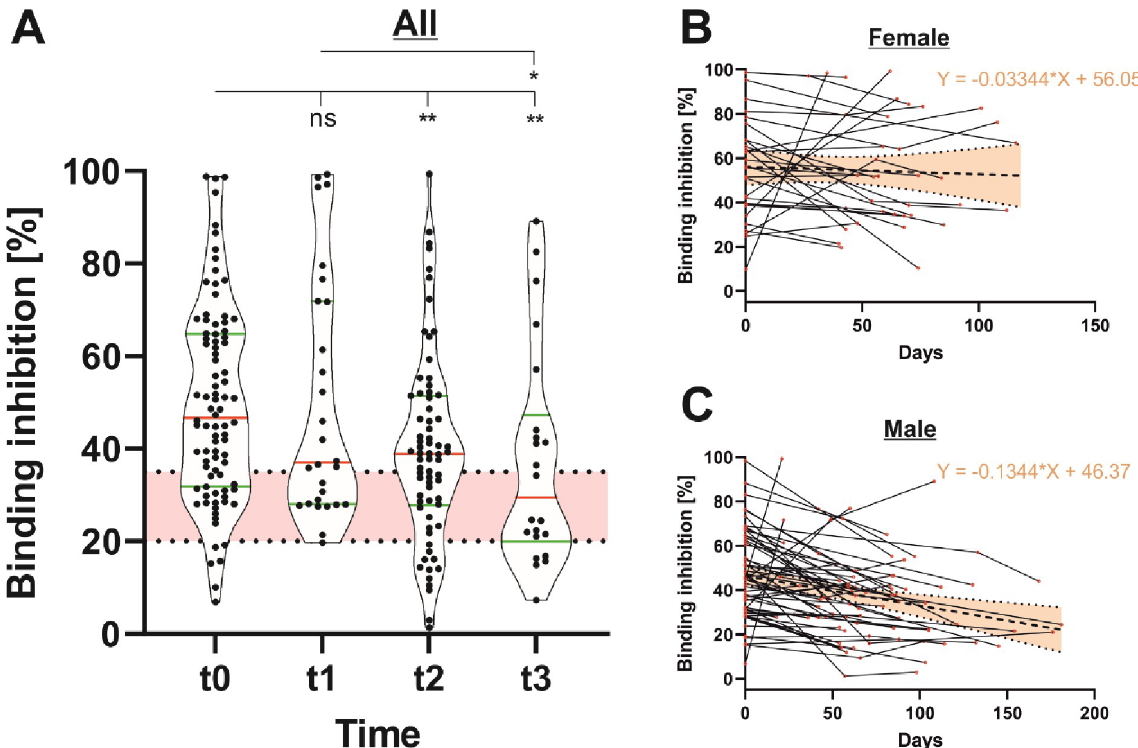
Fig 4. Persistence of anti-SARS-CoV-2-neutralizing antibodies (n = 88). Binding inhibition of anti-SARS-CoV-2-neutralizing antibodies was determined at different time points (t0 = initial seropositivity, t1 = up to 50 days after initial seropositivity, t2 = 50–100 days after initial seropositivity and t3 = 100–200 days after initial seropositivity) using an ELISA-based assay from Euroimmun (A). Considering regression line slopes, neutralizing antibodies were more persistent in female (B) compared to male (C) blood donors.